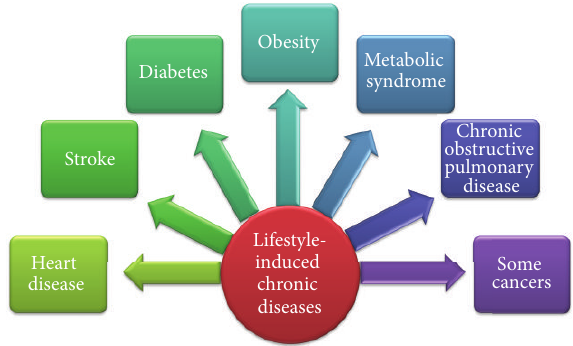
Figure 1: Lifestyle-induced chronic